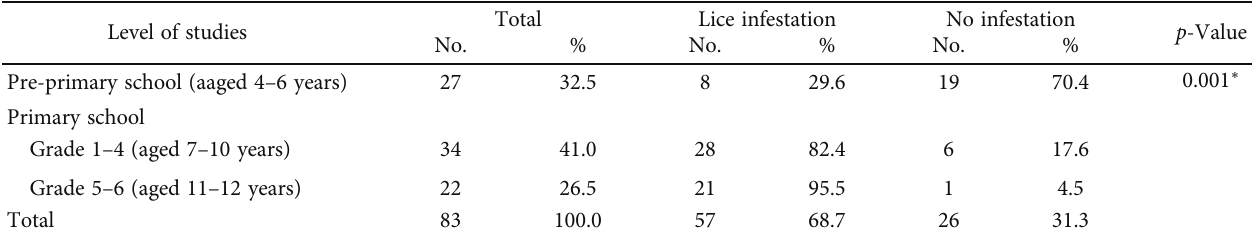
Table 1: The prevalence of head lice infestation and itching sign of infestation cases in schoolchildren in Lak Hok subdistrict. Level of